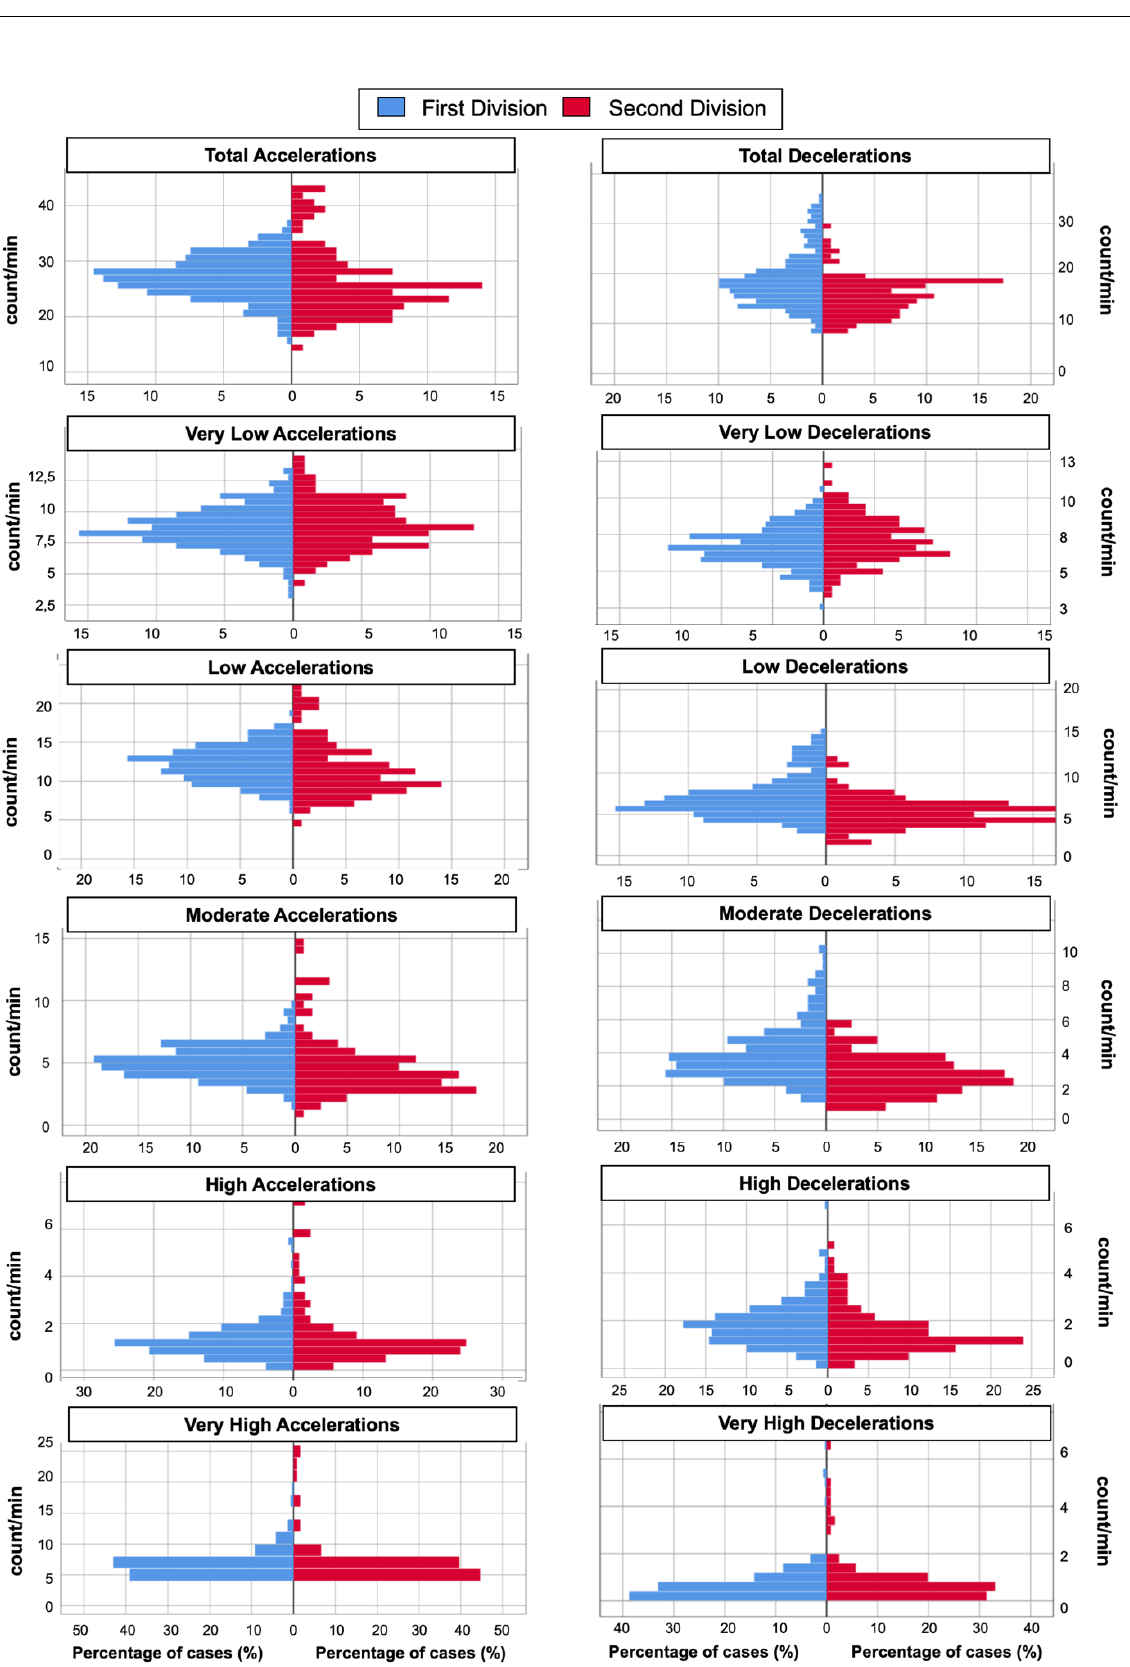
Figure 2. Histogram to represent the external workload demands in five vs. five in women’s basketball in the different acceleration and deceleration zones.